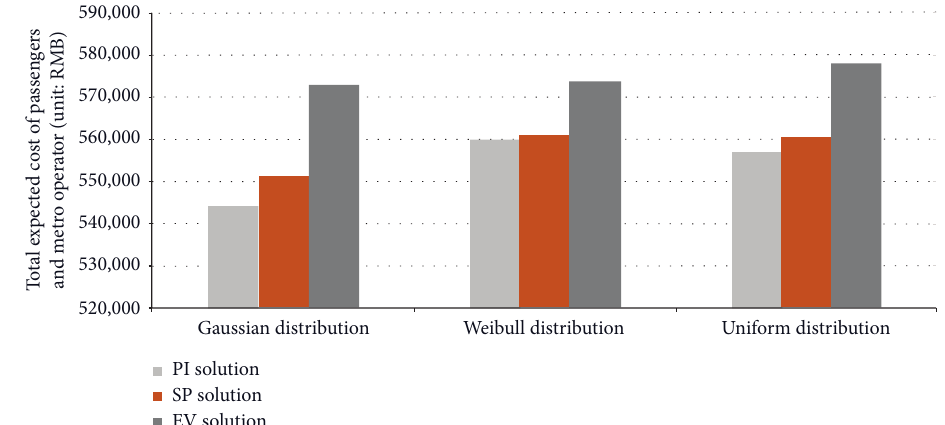
Figure 10: Total expected costs with SP, EV, and PI